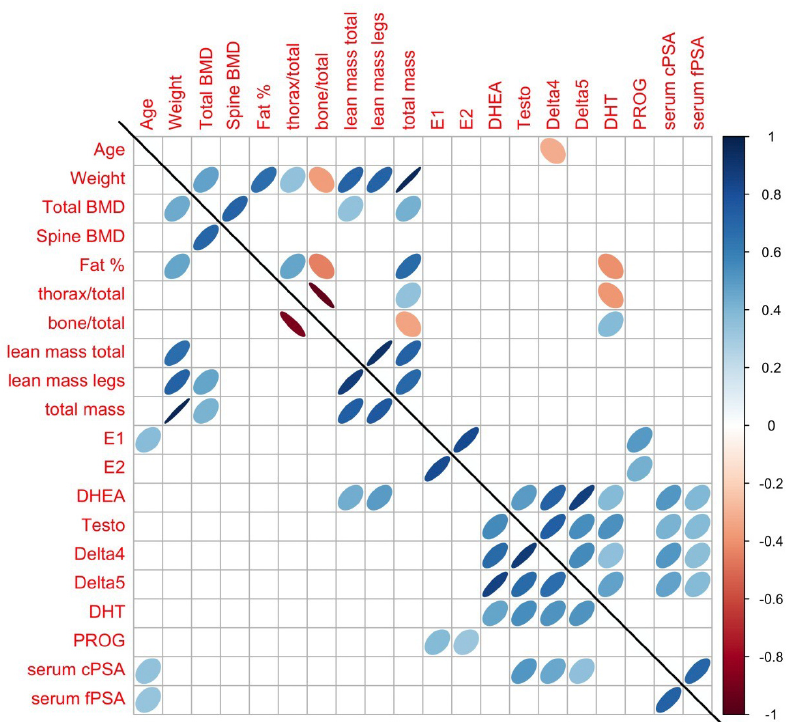
Figure 2. Spearman correlation plots among all variables in athletes (lower diagonal) and controls (upper diagonal) for women not taking hormonal contraceptives. The pairs for which ovals are displayed indicate a Spearman correlation that is significantly different from zero, with p-value< 0.01. See also Table 1 for parameter